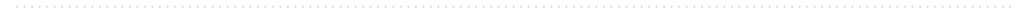
Figure 1. PPP6C is recurrently mutated in melanoma and has a unique relationship to melanocyte lineage and MITF. ( A ) Lollipop plot showing the distribution of PPP6C mutations across the coding protein. The y-axis represents the number of mutations. Data represents PPP6C mutations found in 184 pan-cancer studies. 57/58 tumors containing a PPP6C(R264C) mutation were melanomas. ( B ) Dependency scores derived from CRISPR loss of function screens across multiple cancer and primary cell lines. A gene with a score of less than − 1 is considered essential in that cellular context. ( C ) Gene set enrichment analysis of the transcriptomes of 42 publicly available melanoma cell lines. Plot represents MITF target gene enrichment across increasing PPP6C